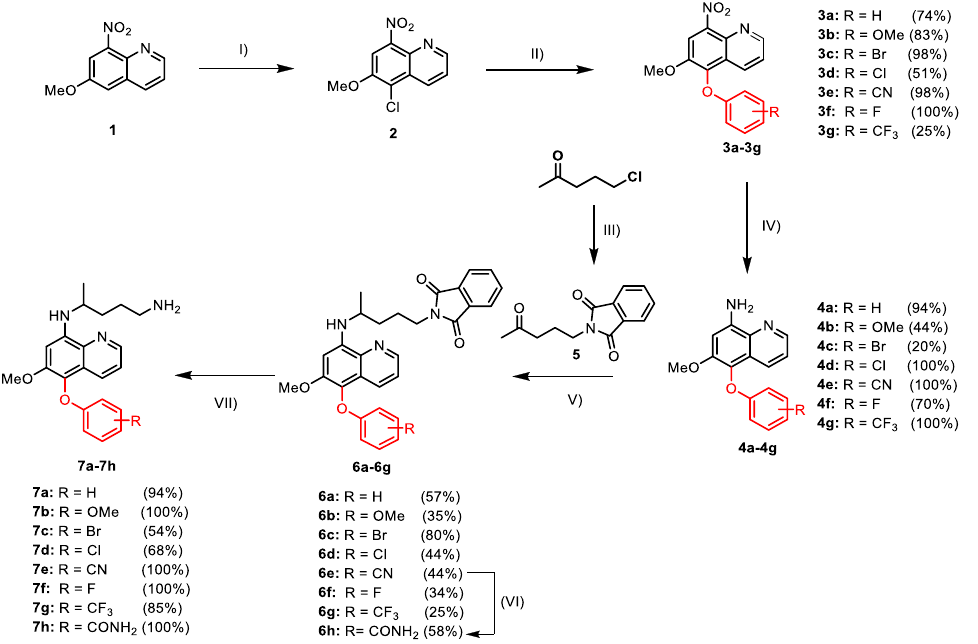
Figure 3. Synthesis of 5-phenoxy primaquine analogs 7a – 7h ; reagents and conditions: (I) NCS (1.5 equiv.), anh. DMF, 60 ◦ C, 3 h, (80–96%); (II) the corresponding phenols (2.0 equiv.), LiOH · H 2 O (2.0 equiv.), DMSO, 100 ◦ C, 3 h; (III) potassium phthalimide (1.0 equiv.), K 2 CO 3 (2.0 equiv.), anh. DMF, 80 ◦ C, 3 h (68–70%); (IV) Sn/HCl (10.0 equiv.), EtOH, r.t., 30 min or Pd/H 2 , r.t., 16 h; (V) 5 (5.0 equiv.), NaBH 3 CN (2.0 equiv.), AcOH, anh. MeOH, r.t., 4 days; (VI) 50% H 2 SO 4 , EtOH, 80 ◦ C, 6 h; (VII) NH 2 NH 2 · H 2 O (5.0 equiv.), EtOH, reflux, 30